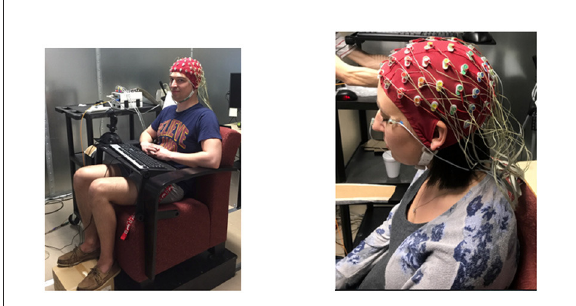
FIGURE4 Left : An example image of our post-training laboratory set-up. Here we collected EEG data during the last two sessions (post-training) of the experiment. Right : An example of the 64-electrode BioSemi system on a human subject using an ECI and external mastoid and EOG